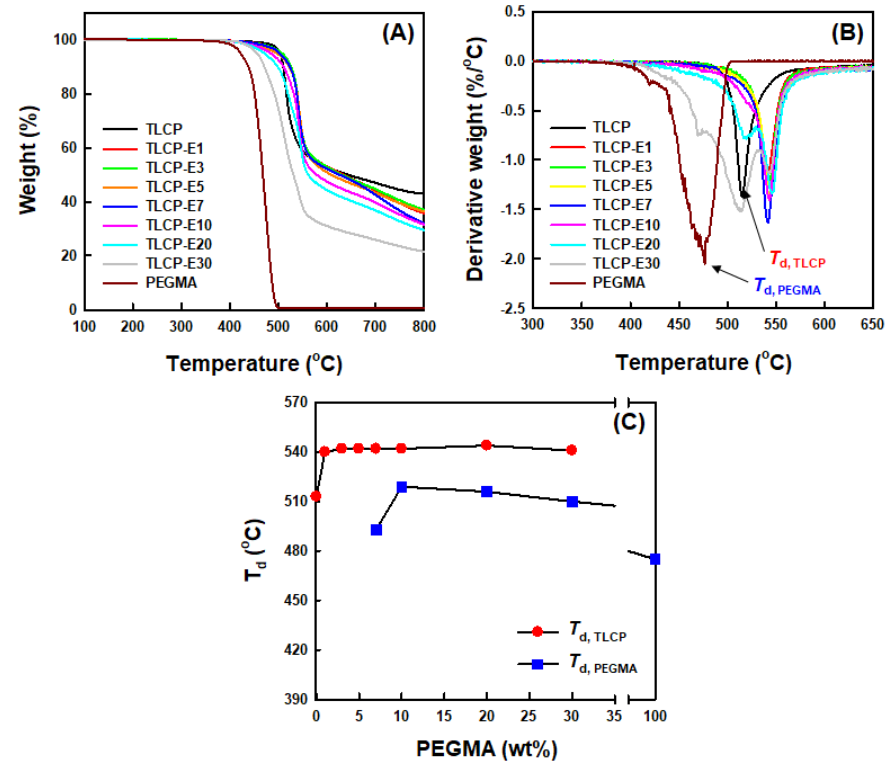
Figure 8. ( A ) Thermogravimetric analysis (TGA) thermograms, ( B ) DTG thermograms, and ( C ) thermal decomposition peak temperatures of neat TLCP, neat PEGMA, and TLCP/PEGMA blends.